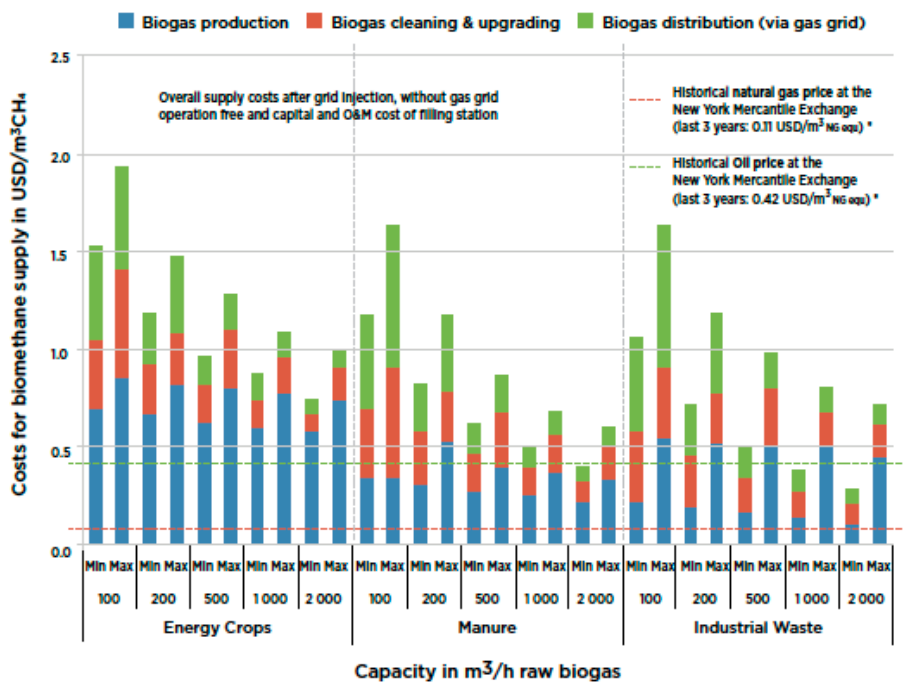
Figure 2. Biomethane cost of production, upgrading and distribution as function of production capacity and feedstock type (source: IRENA 2018 [28]).